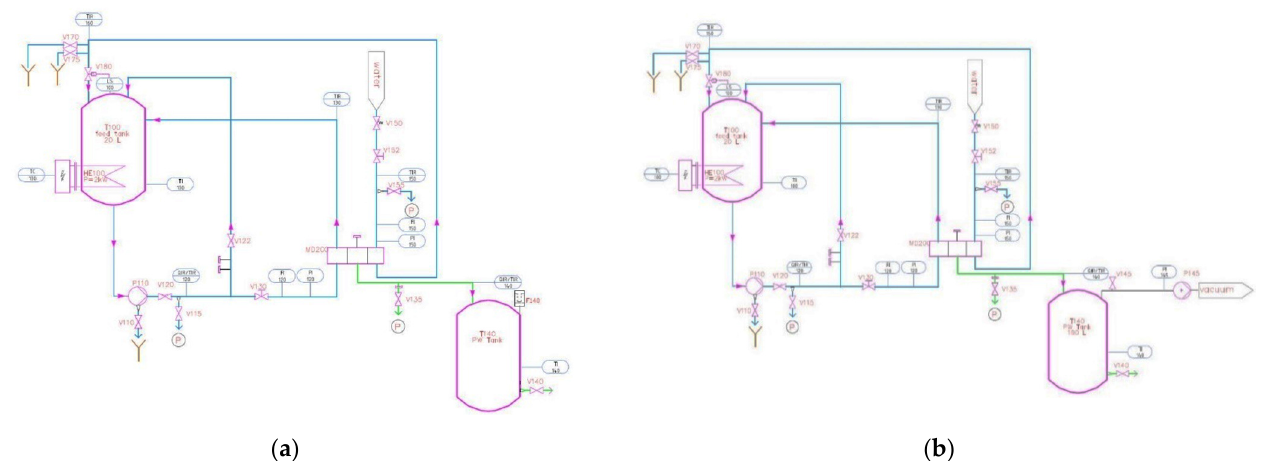
Figure 2. P + I schemes of the test plant. ( a ) AGMD configuration; ( b ) VMD configuration.